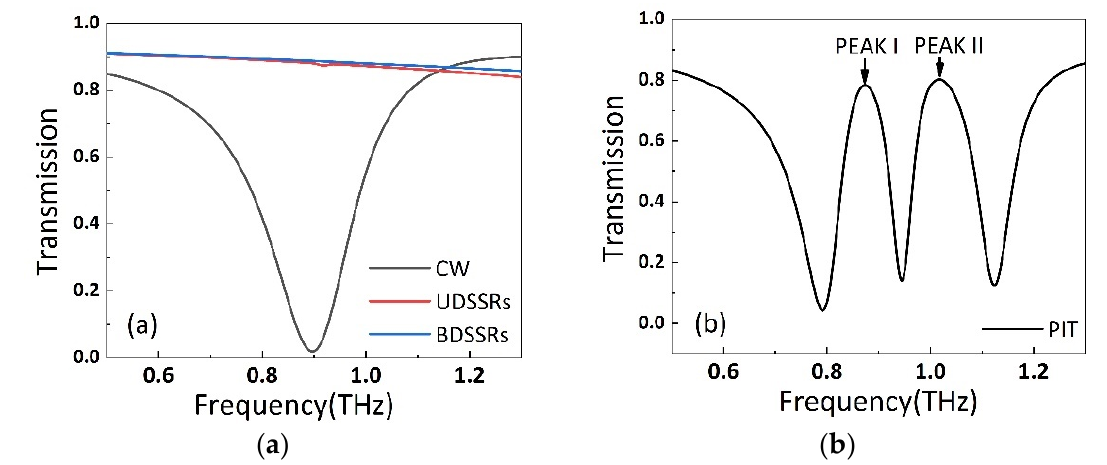
Figure 2. ( a ) The transmission spectra of isolated CW array, BDSSRs array and UDSSRs array. ( b ) The transmission spectra of the PIT metamaterial composed of two parts of DSSRs and CW.